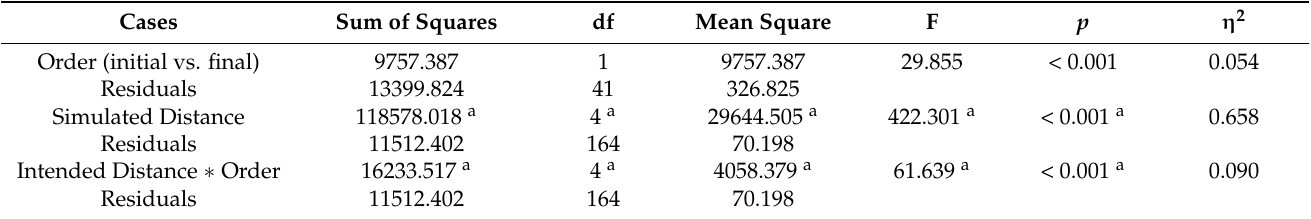
Table A5. Exp 3: Group 1—repeated-measures ANOVA—comparing target positions.